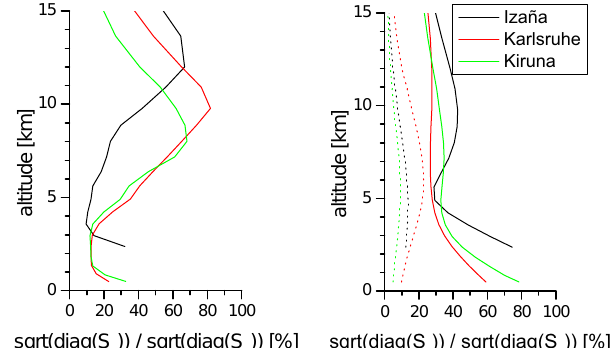
Table 3. Estimated potential temporal and spatial missmatch.